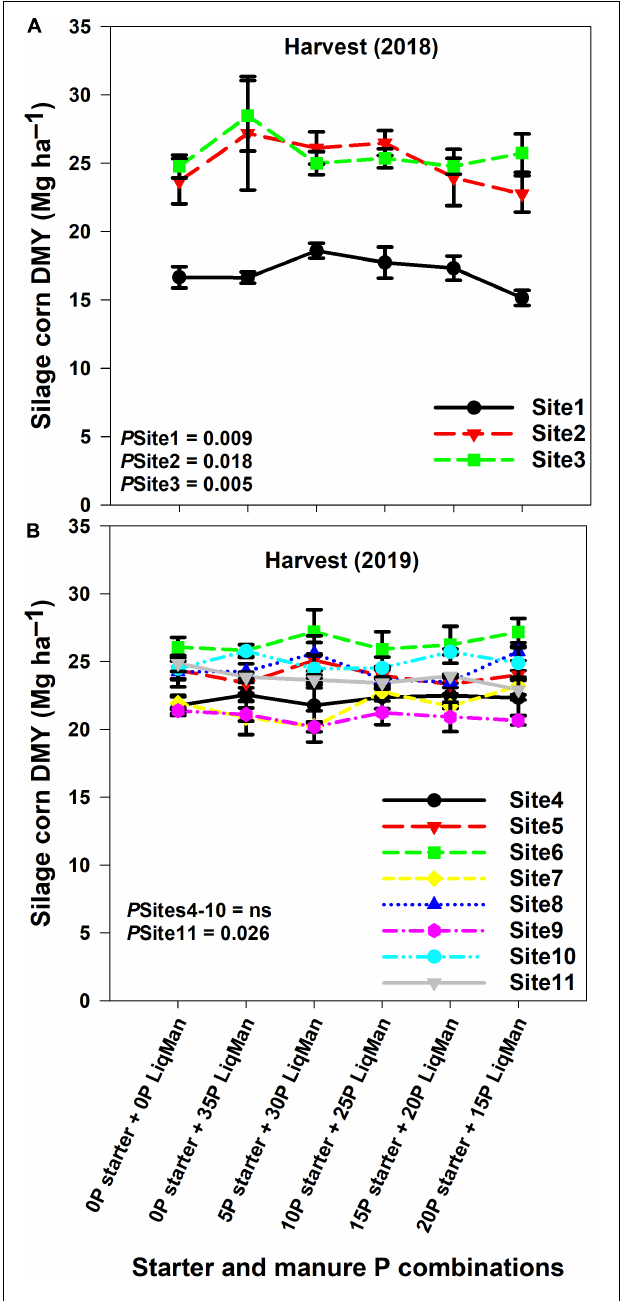
FIGURE 4 | Corn dry matter yield (DMY) at harvest with application of starter P rates and dairy manure across 11 sites [2018 (A) and 2019 (B) ] in the Fraser Valley, BC. Dairy manure was applied at 6-leaf stage. Error bars represent standard deviations of the